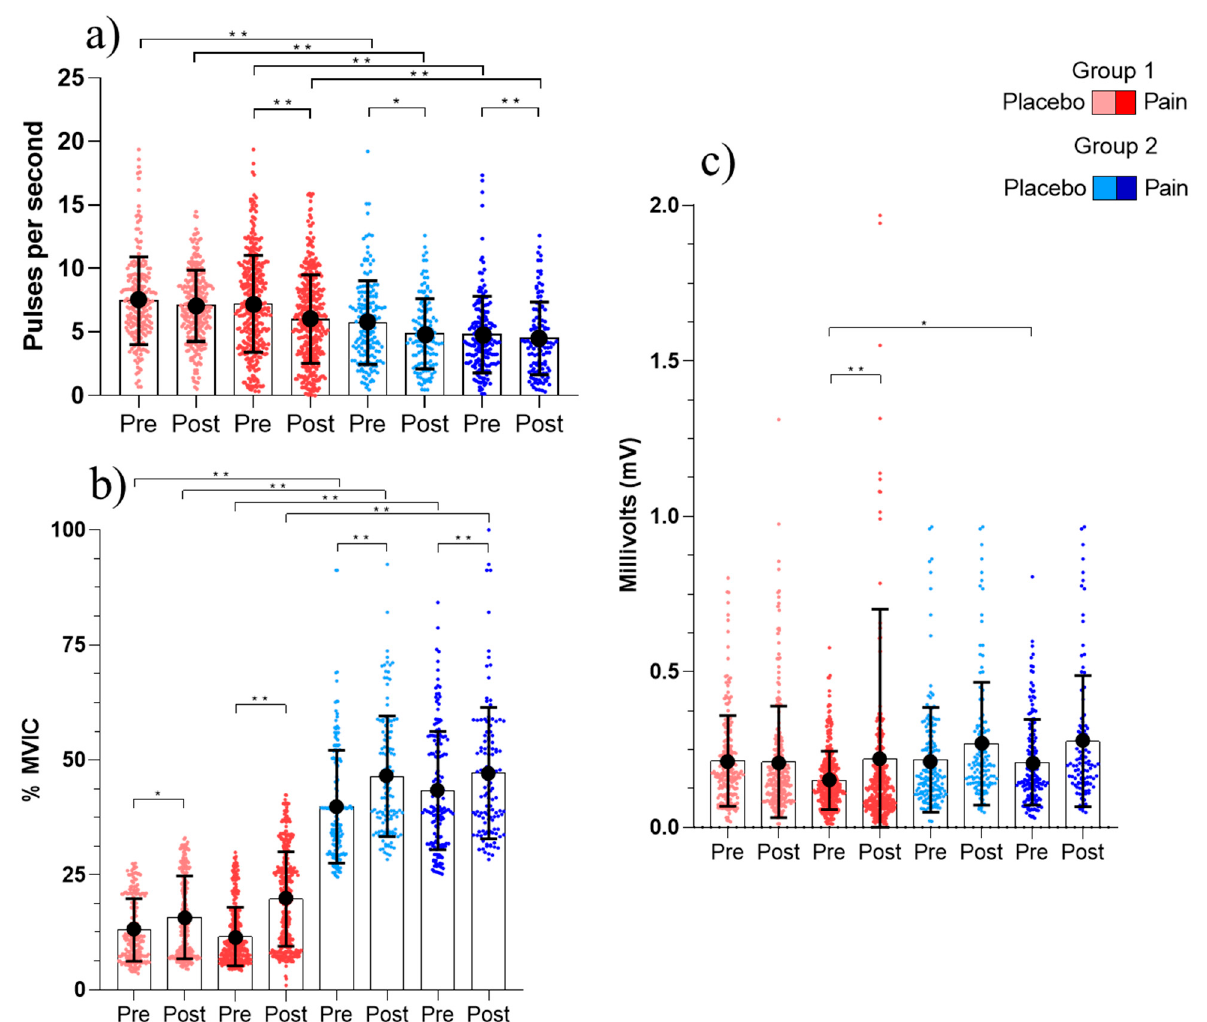
Figure 4. Mean and standard deviation of motor unit variables identified in nineteen subjects during five isokinetic contractions and stratified in epoch, solution type and MU groups. ( a ) Mean firing rate ( b ) recruitment threshold ( c ) MUAP AMP . Data were obtained during baseline (pre) and during (post) experimentally induced pain or placebo. Statistical significance was tested using MANOVA between moments in the same condition (* p < 0.01, ** p < 0.001).